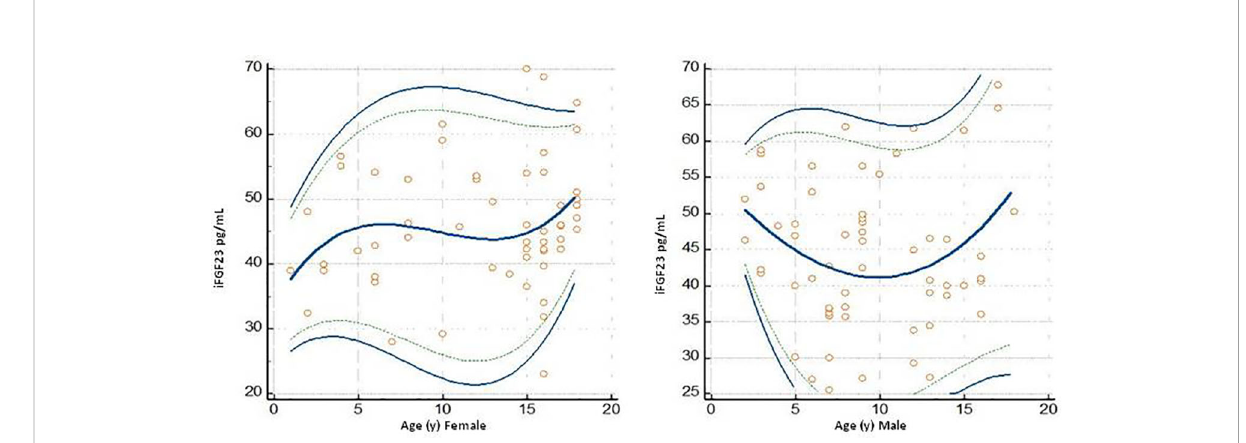
FIGURE 5 Plots dello scatter diagram of the measurements versus sesso (Female and Male) ed age I gra fi ci riportano olte alle singole misurazioni the calculated mean (central line) and centile curves (linea continua 0,025 0,975 centiles, linea discontinua: 0,05-0,95